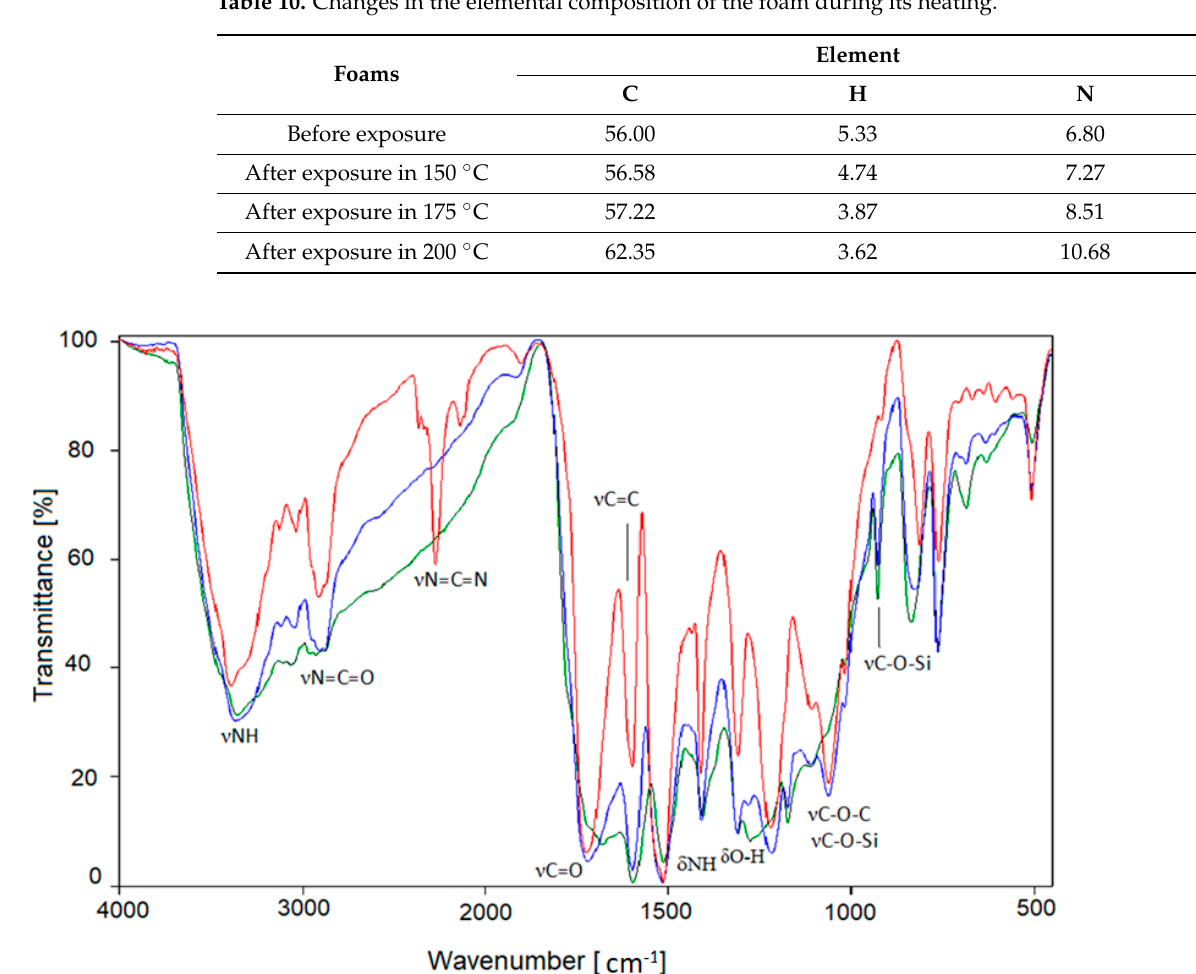
Figure 8. IR spectra of unheated (red) and annealed foam at 150 °C (blue) and 175 °C (green).